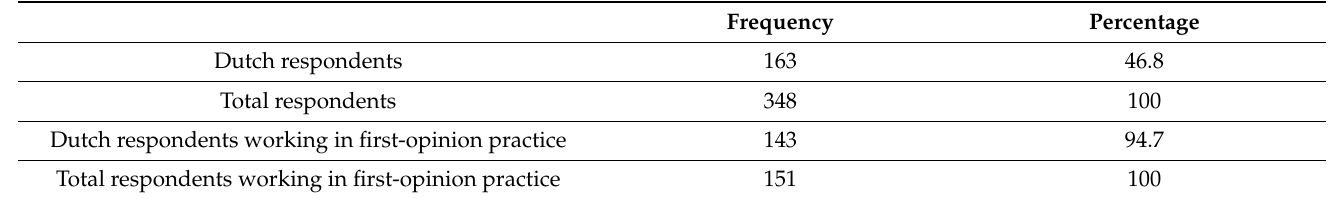
Table A11. Frequency and percentage of Dutch respondents working in first-opinion practice com- pared to total respondents working in first-opinion